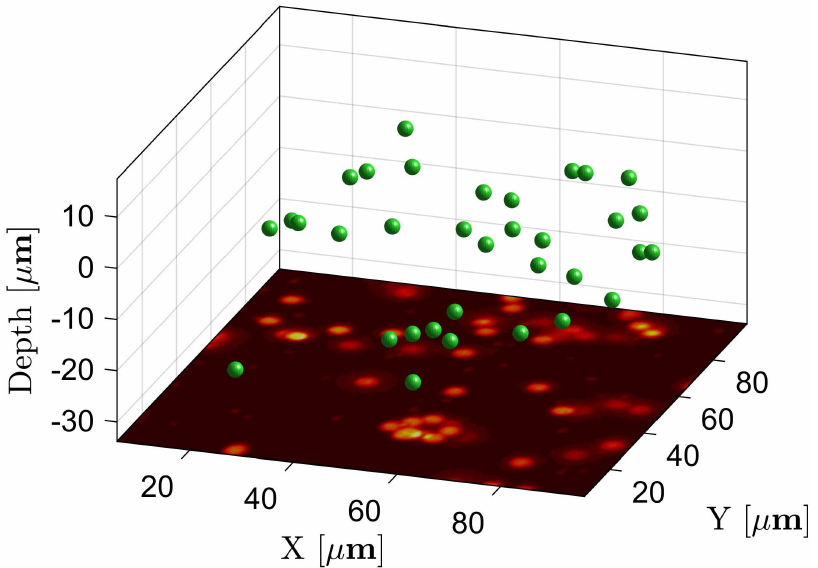
Fig 7. Volumetric imaging of dynamic samples and 3D Reconstruction. The fluorescent beadsare moved at an averagespeed of about 1 μ m/s by driving the sample stage. See S1 Movie for the dynamic